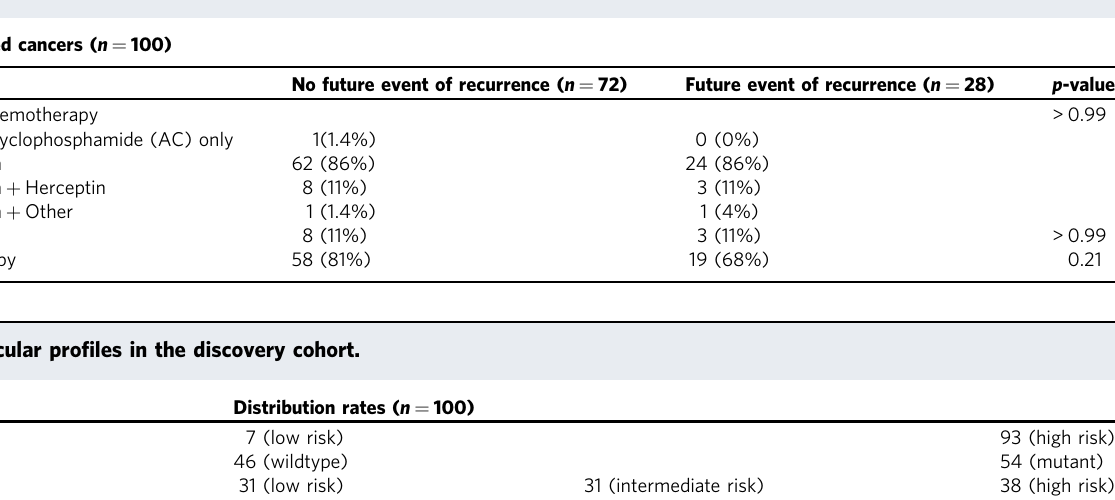
Table 2 Selected treatment characteristics for discovery cohort.